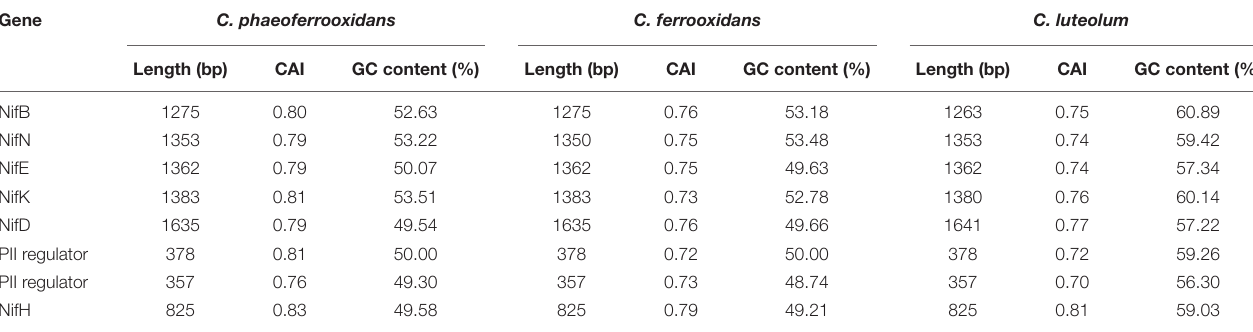
TABLE 1 | Gene length (bp), codon adaptation index (CAI), and GC content (%) for each of the genes in the nitrogenase cassette. Gene